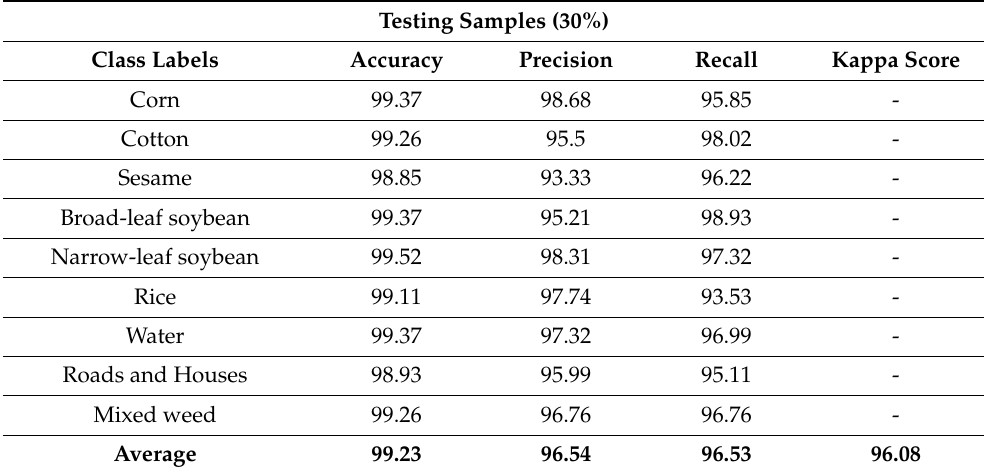
Table 3. Result analysis of the SSODTL-CC technique with distinct classes under 30% of testing